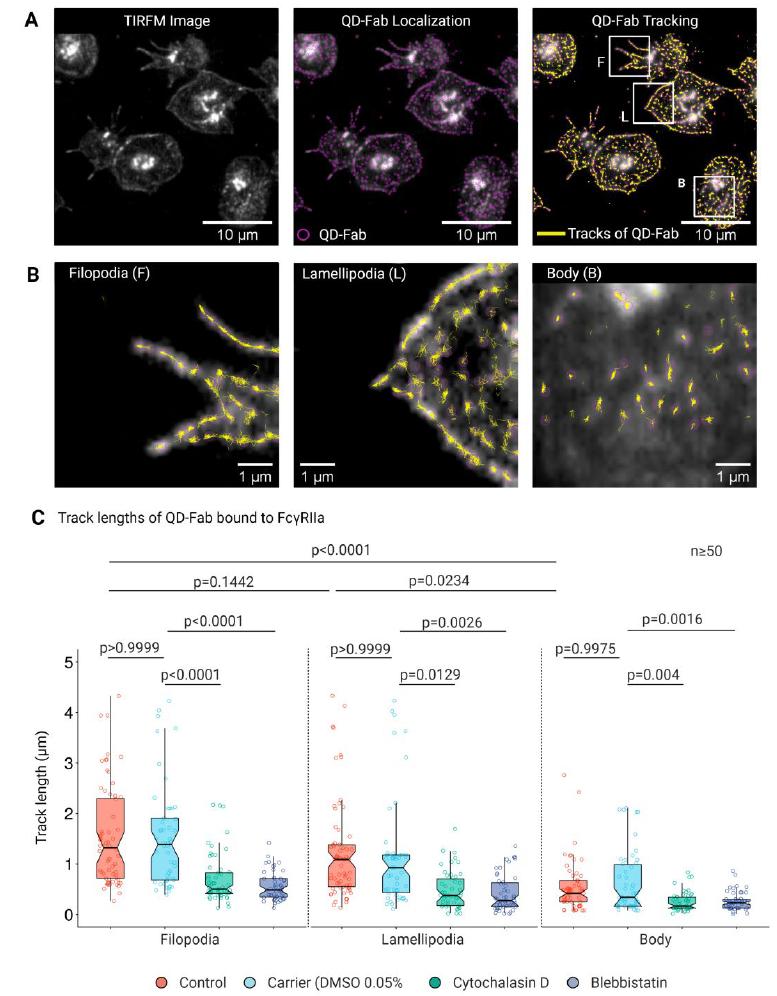
Figure 5. Single-particle tracking of Fc γ RIIA on platelets using QD-Fab. ( A ) Fluorescence mi- crographs showing platelets labeled with QD + anti-Fc γ RIIA Fab bound to Fc γ RIIA followed by localization of single Fc γ RIIA by detection of single QD fluorescence emission (magenta) and overlay of tracks (yellow) identified from ( B ) time-lapse images of single QD-Fab bound to individual Fc γ RIIA along the filopodia (F), lamellipodia (L), and platelet body; Analysis of track length ( C ) from trajec- tories of single QD- Fab bound to FcγRIIA on filopodia, lamellipodia, and platelet body. Statistical comparisons were performed by one-way ANOVA on ranks (non-parametric), followed by Dunn’s multiple comparisons test. Boxplots extend from 10 to 90 percentiles, and p < 0.05 is significant and n ≥ 50 single QD-fab per dataset.